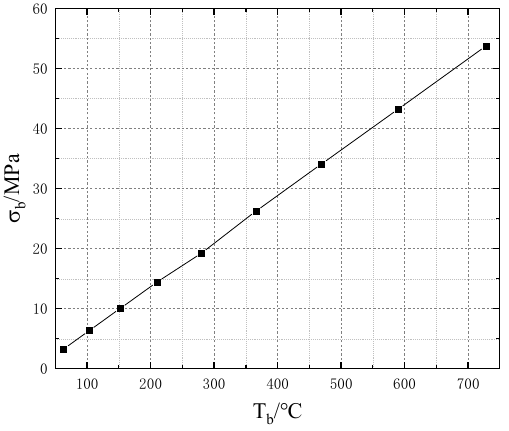
Figure 12. Relationship between σ (cid:2912) and T (cid:2912) .